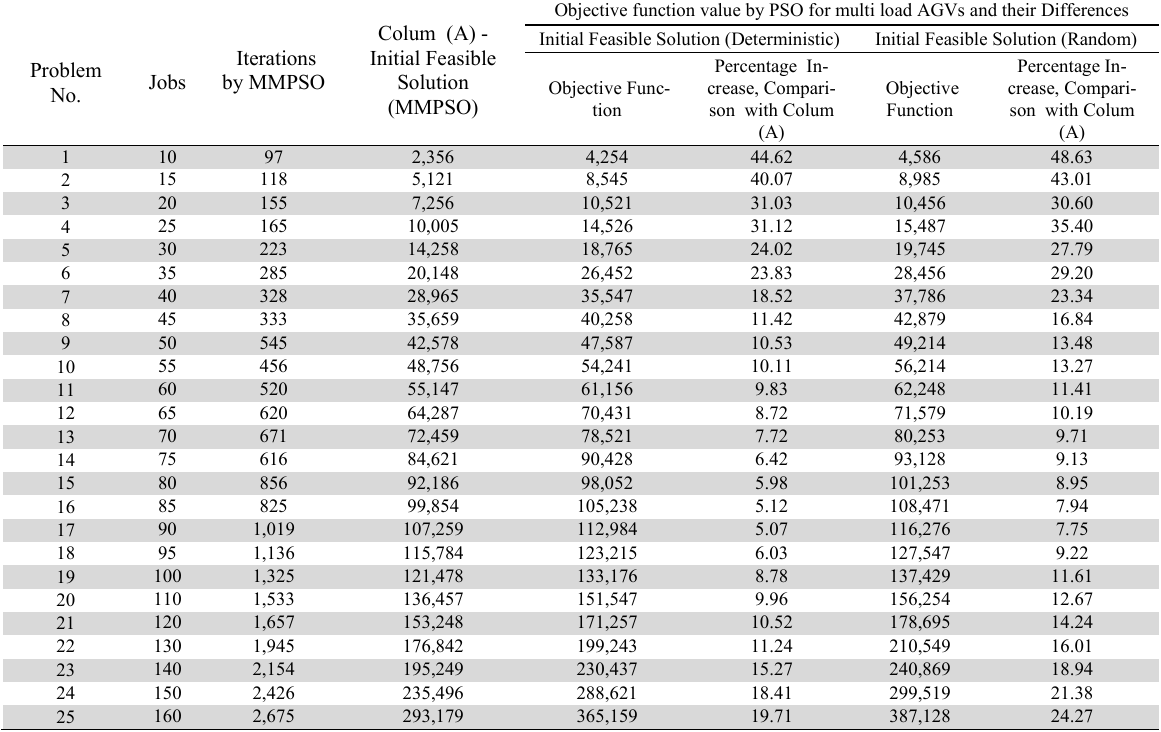
Comparison of Initial Feasible Solutions by PSO and MMPSO Iterations Problem by No.